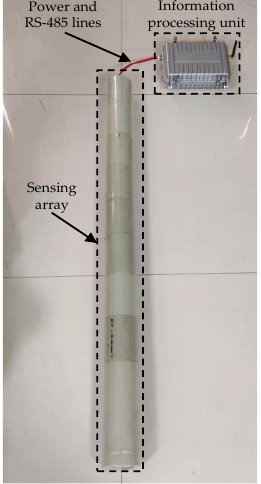
Figure 4. Details of the deep displacement monitor sensor.